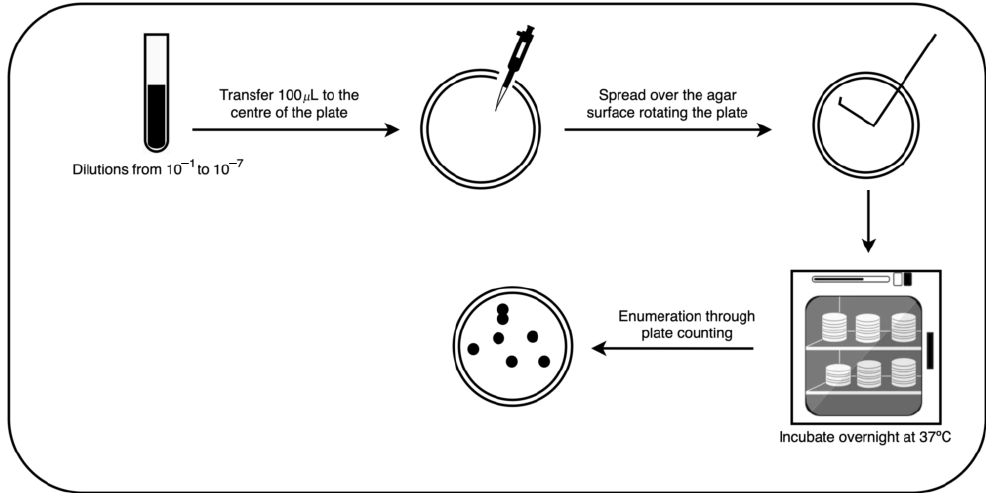
Figure 1. Spread plate